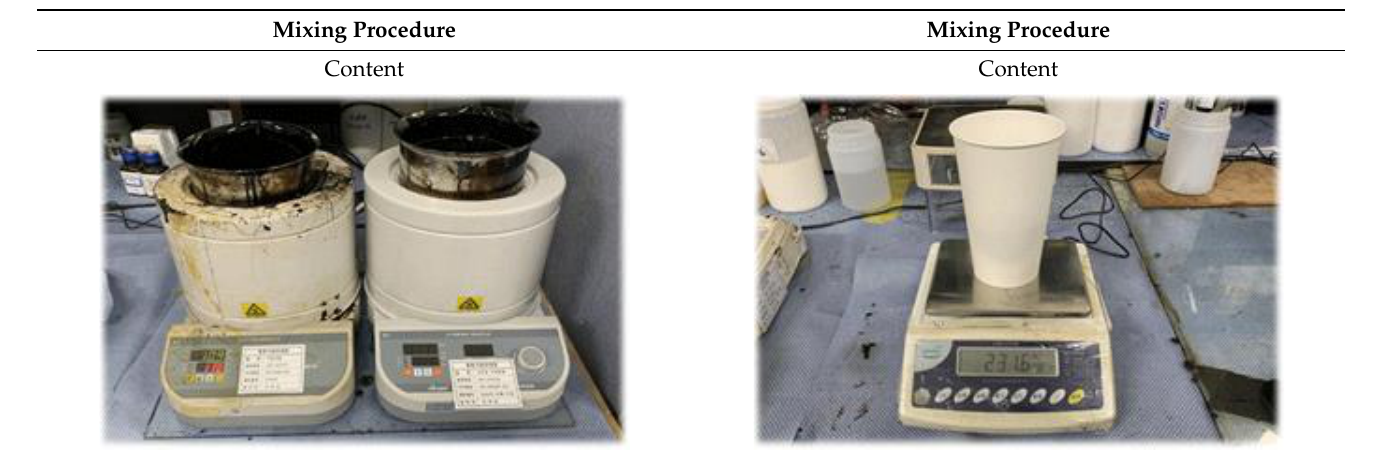
Table 12. Complex additive formulation